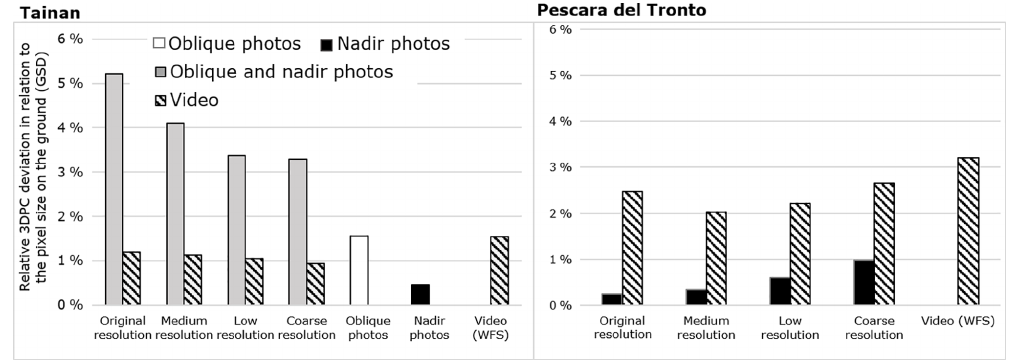
Figure 6. Planar fitting analysis of Tainan and Pescara del Tronto 3-D point clouds as part of the internal 3-D quality assessment. Comparison of the mean distance of 3-D points to the theoretical planar object. Larger distance implies lower 3-D point cloud precision.